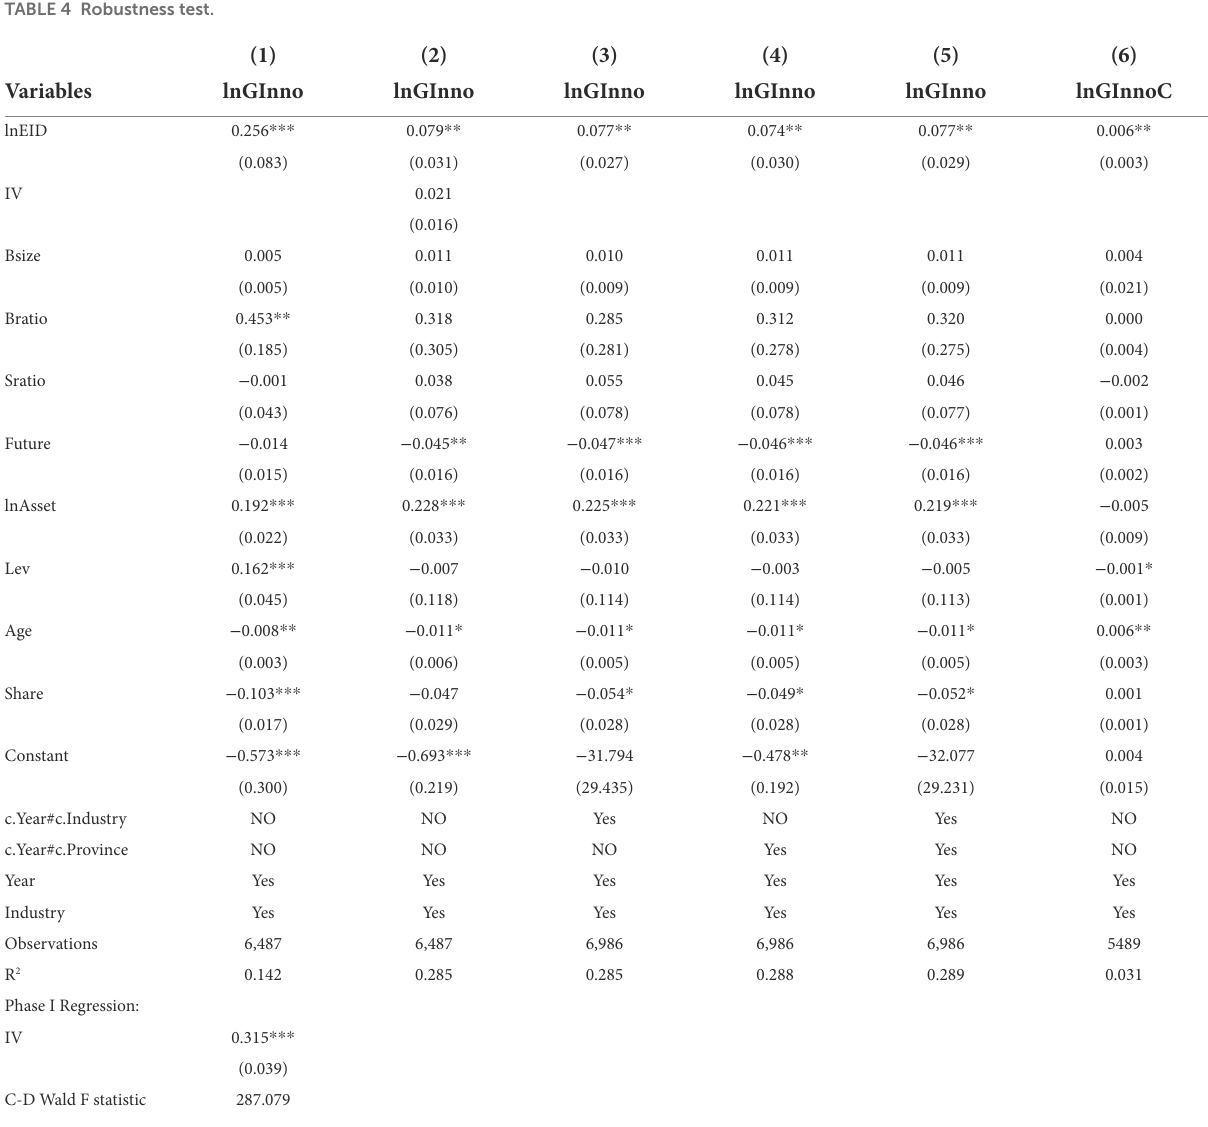
TABLE 4 Robustness